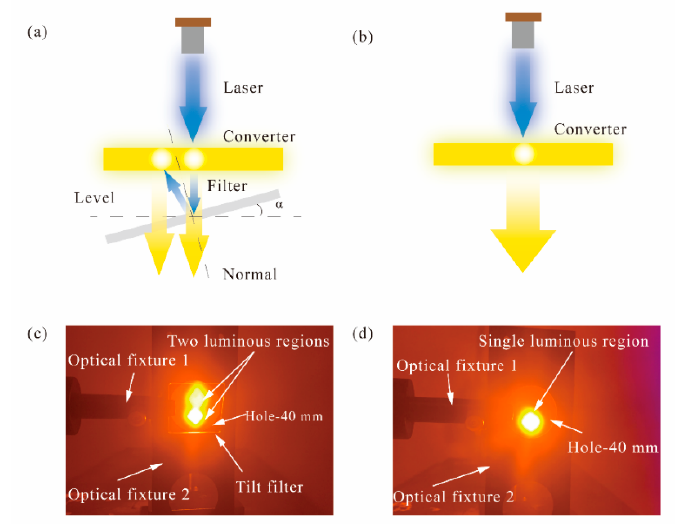
Figure 2. Diagrams of ( a ) micro-angle tunable tilted filters (ATFPCs) and ( b )conventional phosphor converters (CPCs); actual lighting effect images of ( c ) CPCs and ( d ) ATFPCs under a brown filter to protect the camera.